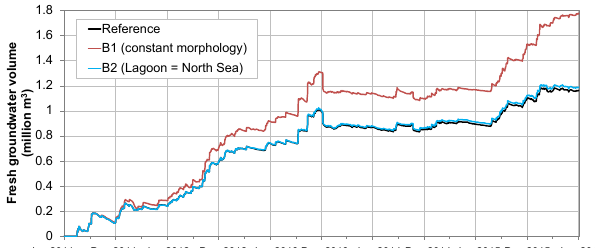
Figure 12. Increase in the volume of fresh groundwater from June 2011 to May 2016, for the reference case (with hindcast of the la- goon water level), model scenario B1 (constant morphology), and model scenario B2 (lagoon water level equal to North